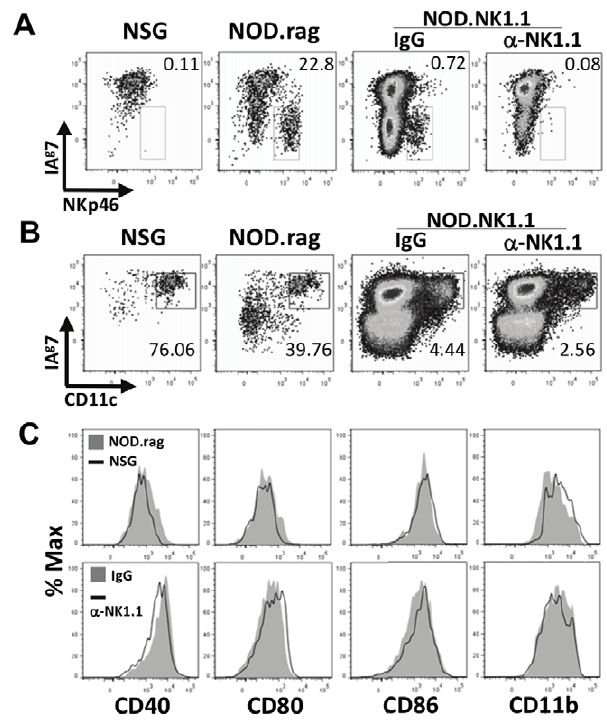
Figure 6. NK cells do not influence intra-islet DC maturation in NOD mice. A) NK cells were not detected in islets from NSG mice (first panel on left) or NOD.NK1.1 mice treated with anti-NK1.1 (far right panel), but were found in islets from Rag2 2 / 2 NOD mice and NOD.NK1.1 mice treated for 8 weeks with isotype-matched control IgG. Plots are of CD45 + cells isolated from islets of 10 week-old mice and numbers represent percentages of total CD45 + cells. B) DCs were detected in islets of NSG and Rag2 2 / 2 NOD mice, and in the islets of NOD.NK1.1 mice treated with isotype-matched control IgG or anti- NK1.1 ( a -NK1.1). Plots are of CD45 + cells isolated from islets of 10 week- old mice and numbers represent percentages of total CD45 + cells. C) NK cells in Rag2 2 / 2 NOD mice do not promote DC maturation relative to the NK cell-deficient NSG mice (top row) as there was no difference in maturation marker expression on DC in Rag2 2 / 2 NOD and NSG mice. NOD.NK1.1 mice treated with anti-NK1.1 or an isotype-matched control IgG have DCs of similar maturation status (bottom row). One representative experiment of three independent experiments is shown.